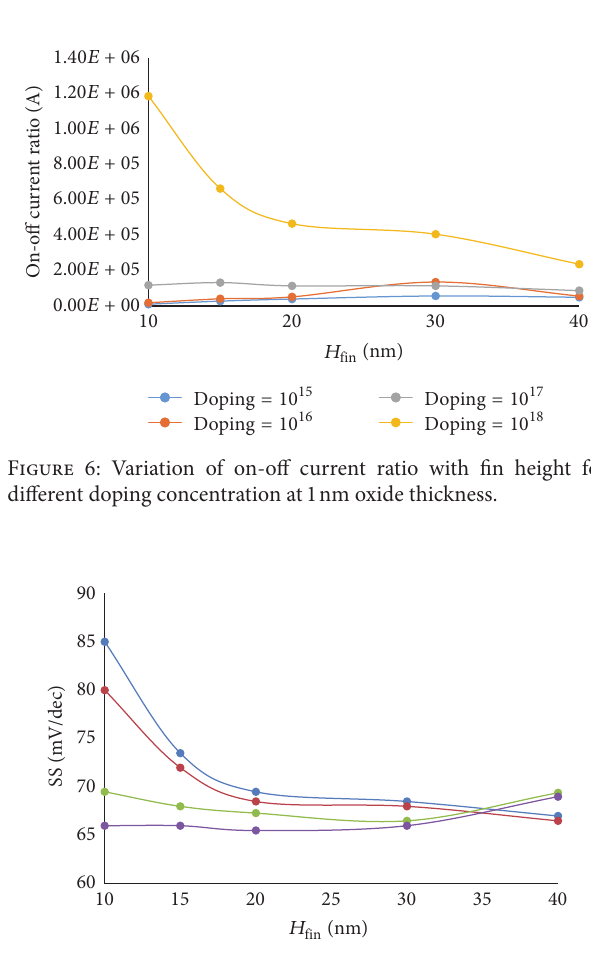
Table 2: Variation of 𝑊